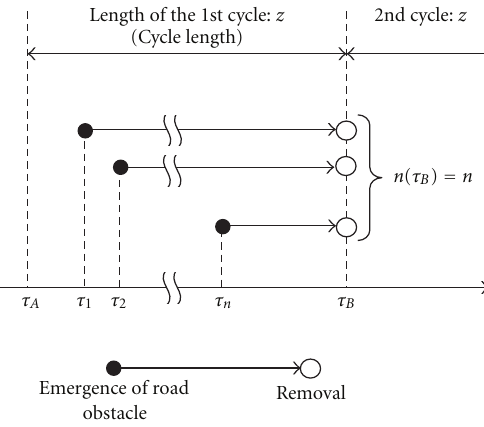
Figure 1: Emergence process of road